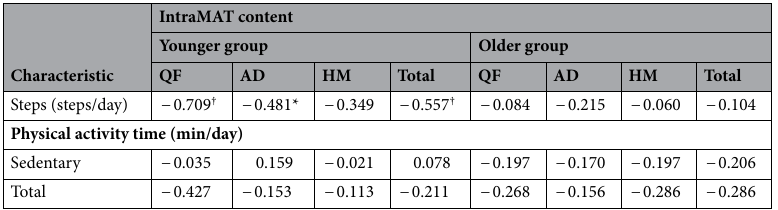
Table 4. Correlation between physical activity and intramuscular adipose tissue (IntraMAT) content in the younger and older groups. * P < 0.05, † P < 0.01 , QF quadriceps femoris, AD hip adductors, HM hamstrings.